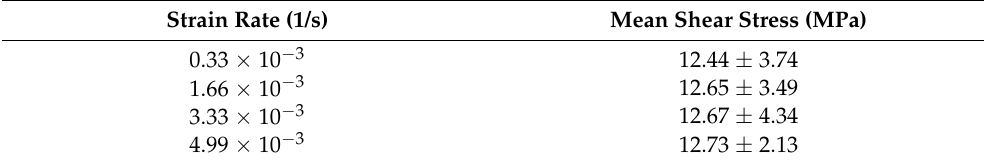
Table 6. Nominal shear stress at different strain rates, category